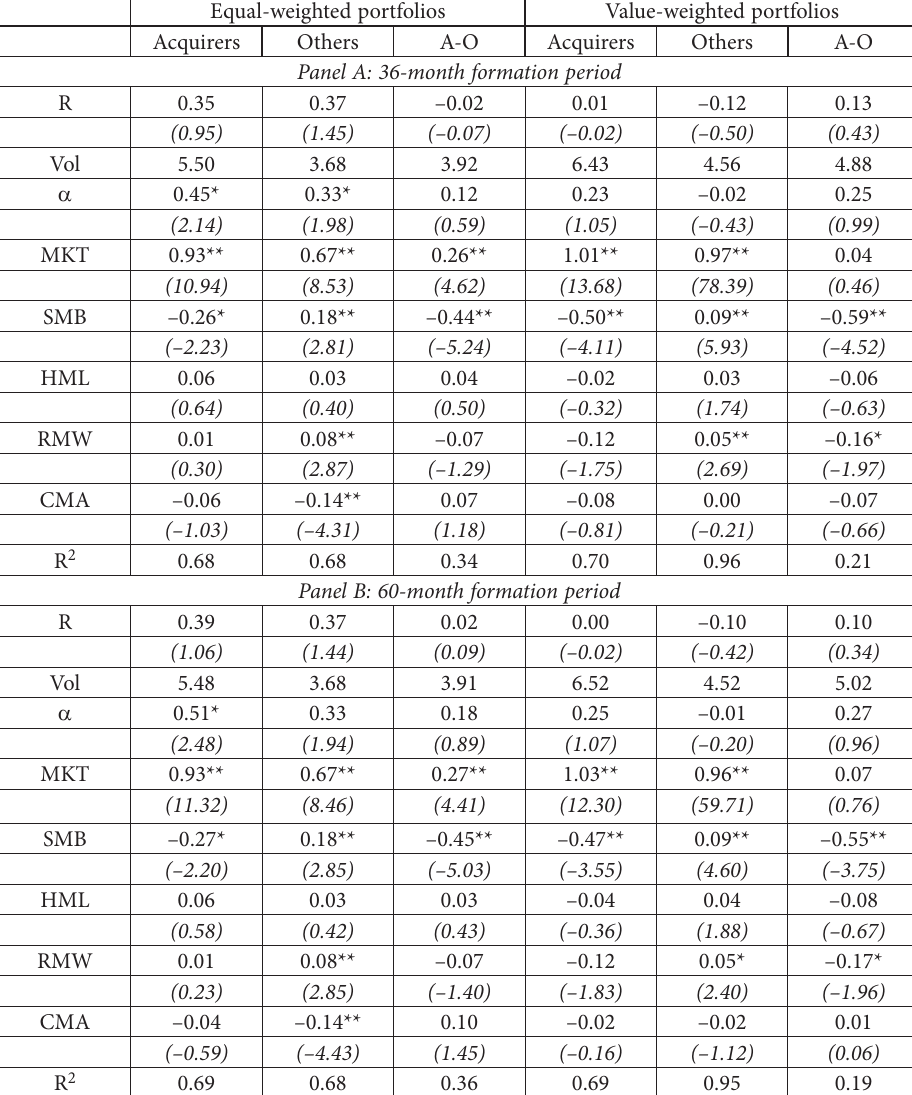
Table 1. Performance of calendar-time portfolios of acquirers Equal-weighted portfolios Value-weighted